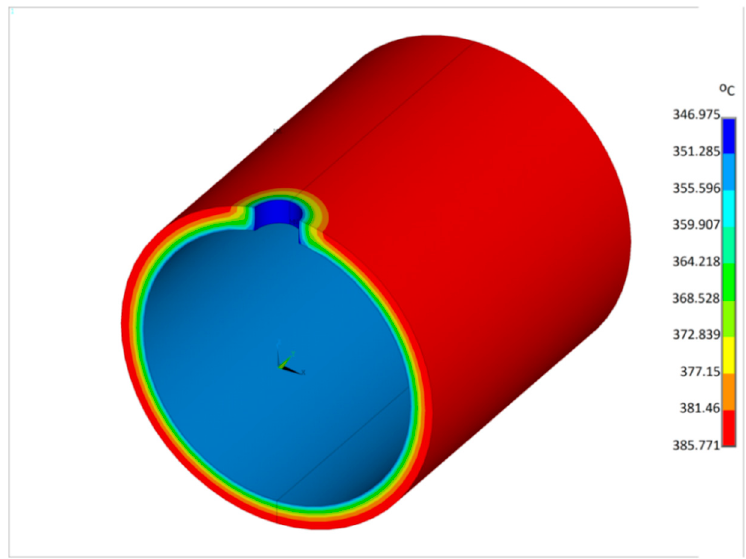
Figure 17. Temperature distribution in the outlet header in time 688 s; at this moment, the stresses reach their highest value according to the new measuring technique.